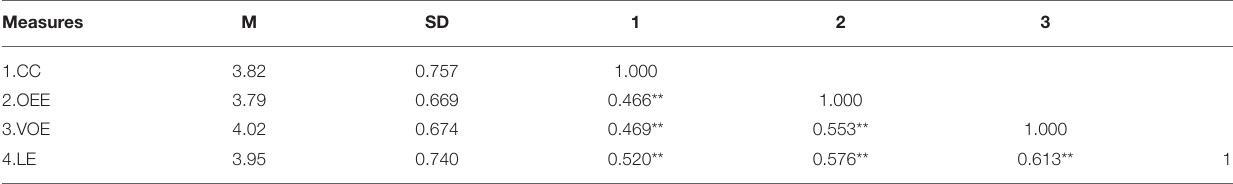
TABLE 1 | Means, standard deviations, correlations, and reliabilities.